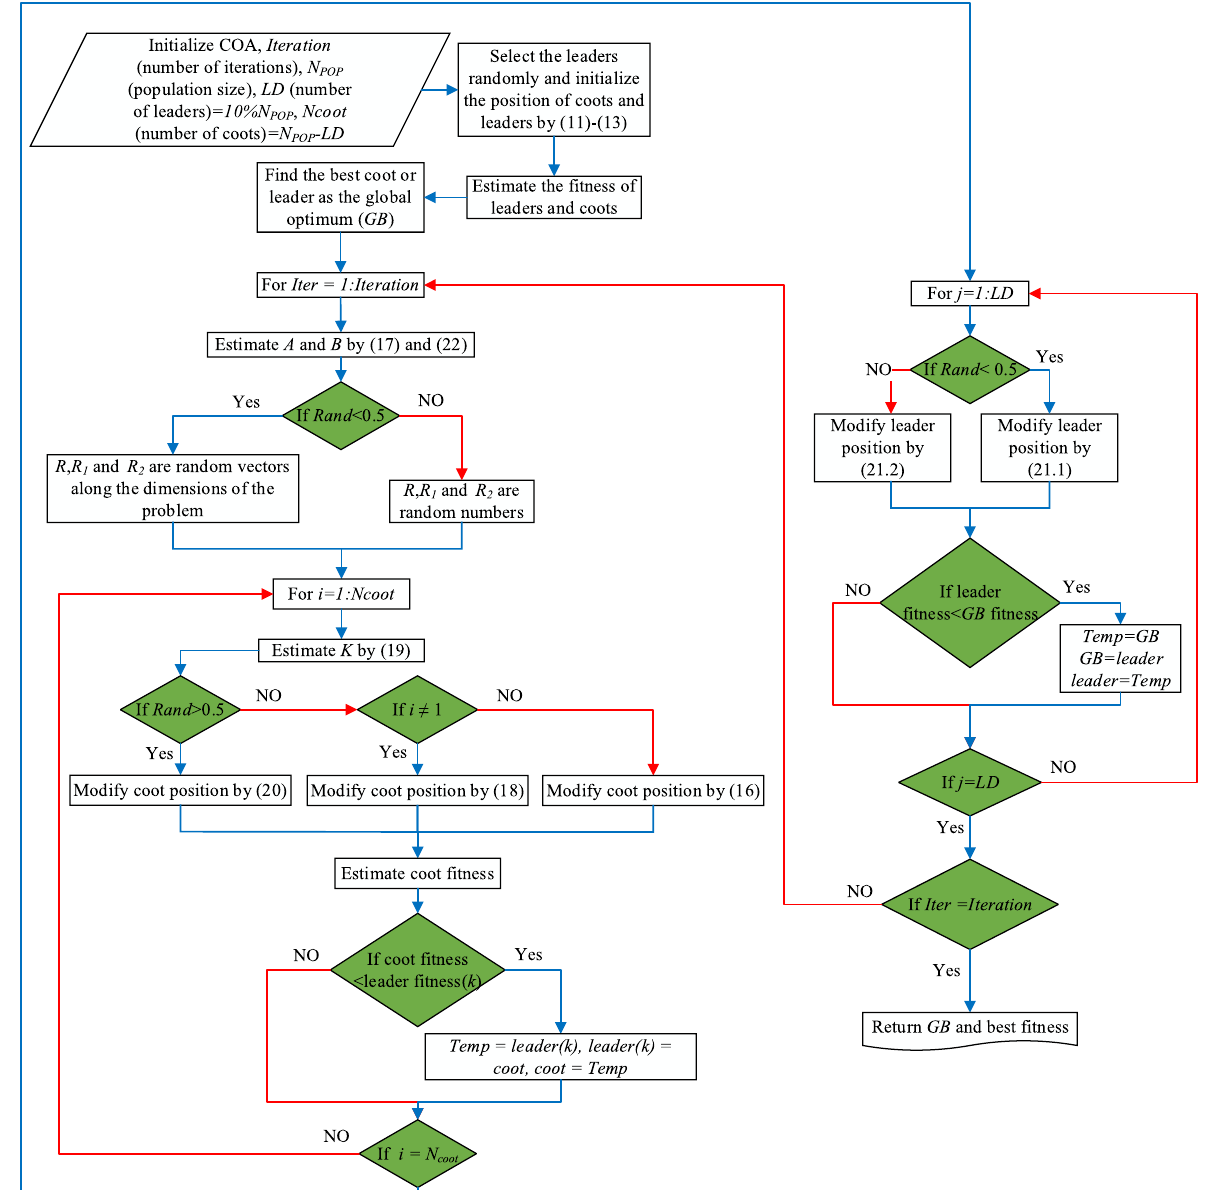
Fig. 13, and the system responses (cid:31) F 1 , (cid:31) F 2 and (cid:31) P 12